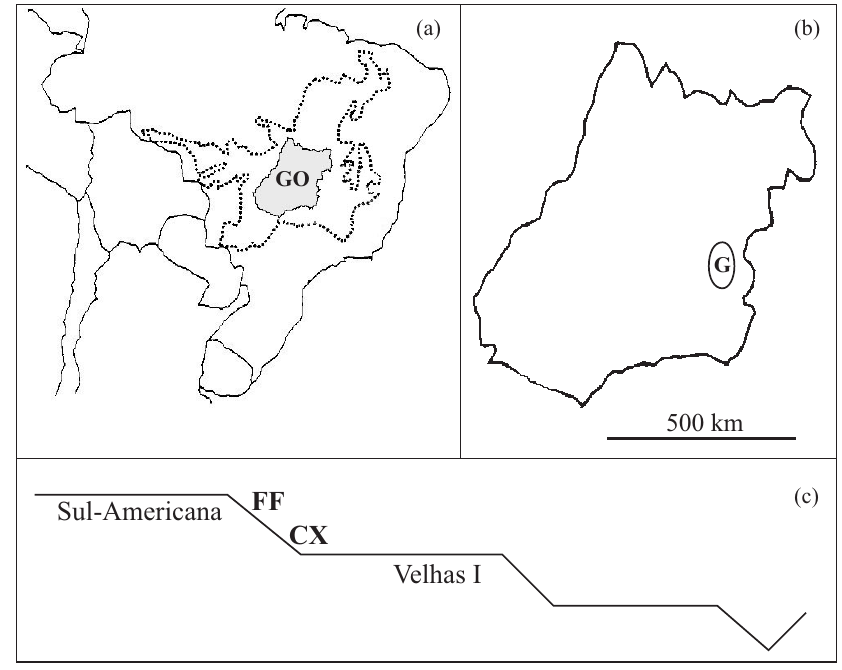
Figura 1. Mapa do Brasil, mostrando a região dos Cerrados e o Estado de Goiás (GO) (a). Mapa do Estado de Goiás, mostrando a localização aproximada da área de estudo – leste de Goiás (G) (b). Esquema mostrando as duas posições de amostragem (código dos perfis de solo) (c), conforme a superfície geomórfica da área de estudo (adaptado de Marques,